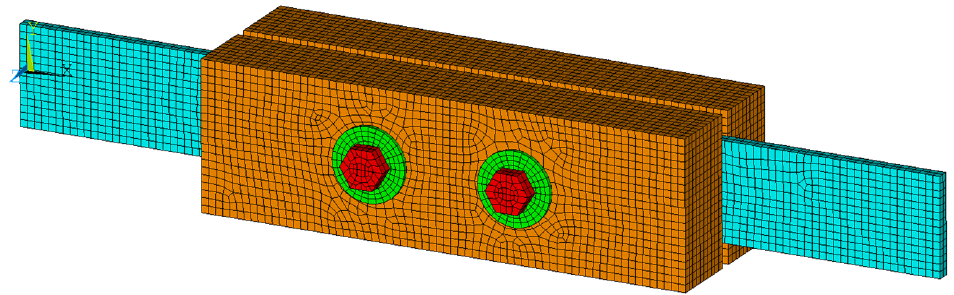
Figure 14. Numerical model and quality of the mesh for H1-type connection in ANSYS Mechanical APDL.